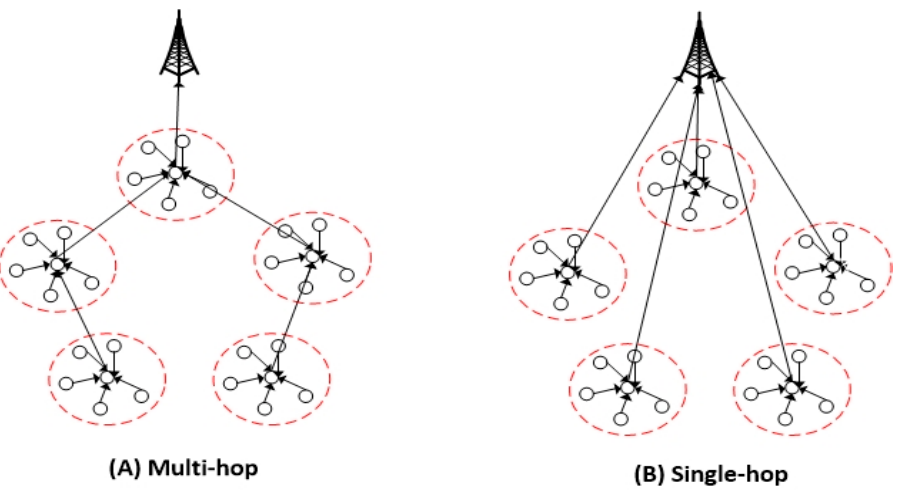
Figure 2. The structure of the clustering routing protocol.